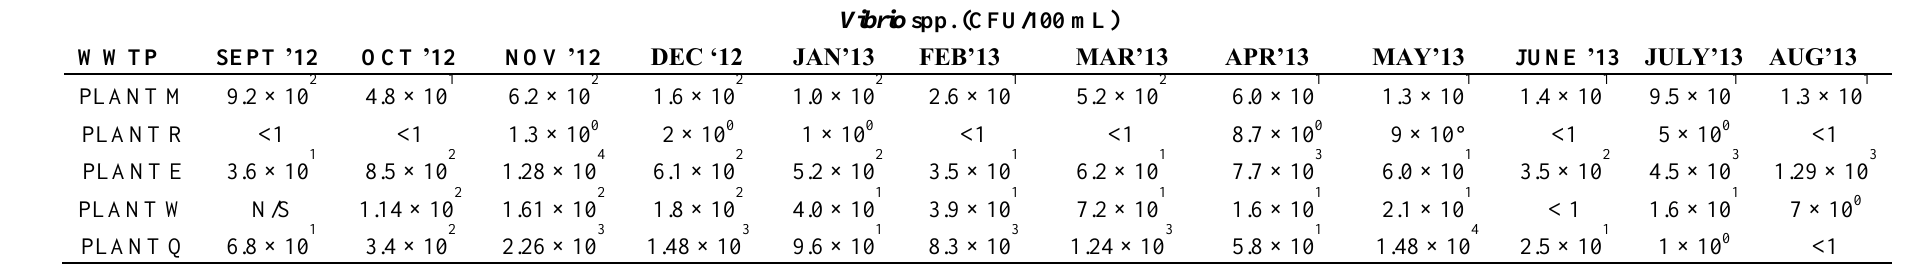
Table 3. Occurrence of Vibrio spp. in selected WWTPs from the Amathole and Chris District Municipalities. Vibrio spp. (CFU/100